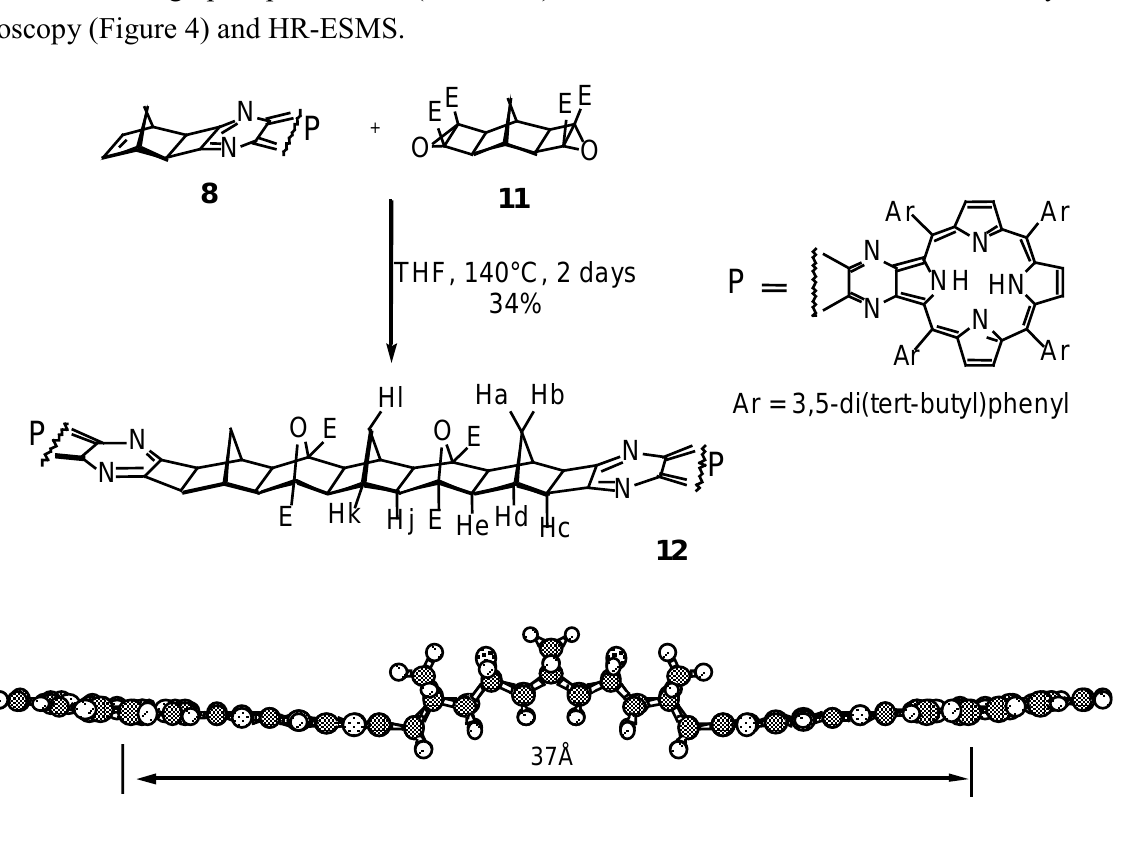
Scheme 4: Synthetic scheme outlining the isolation of bis -porphyrin 12